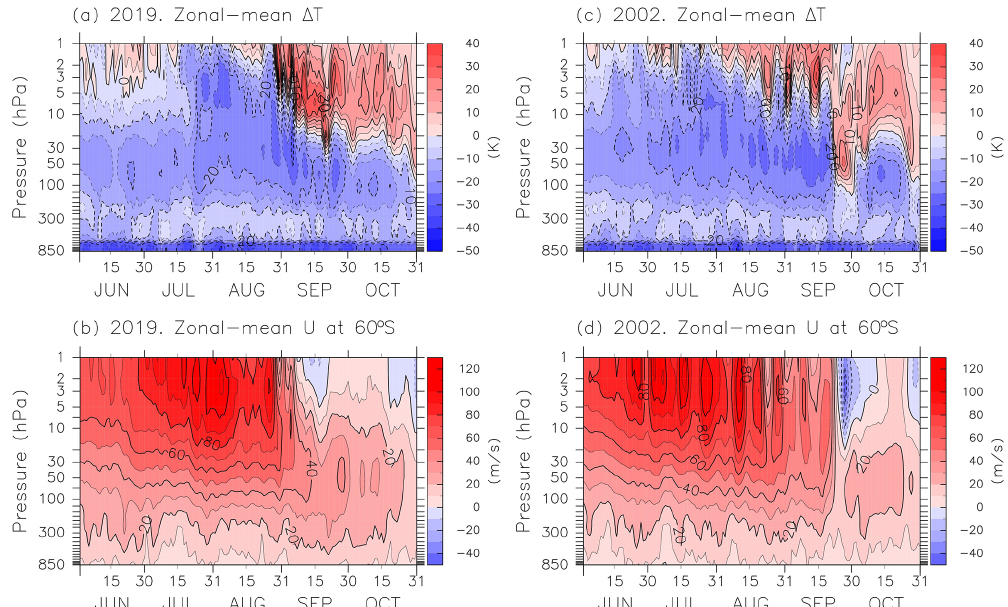
Figure 1. Time–height cross-sections of the temperature difference (K) between 60 ◦ S and the South Pole (a, c) and the zonal-mean zonal wind (ms − 1 ) at 60 ◦ S (b, d) from 1 June to 31 October for 2019 (a, b) and 2002 (c, d) . The contour intervals are 5K for temperature and 10ms − 1 for zonal wind,